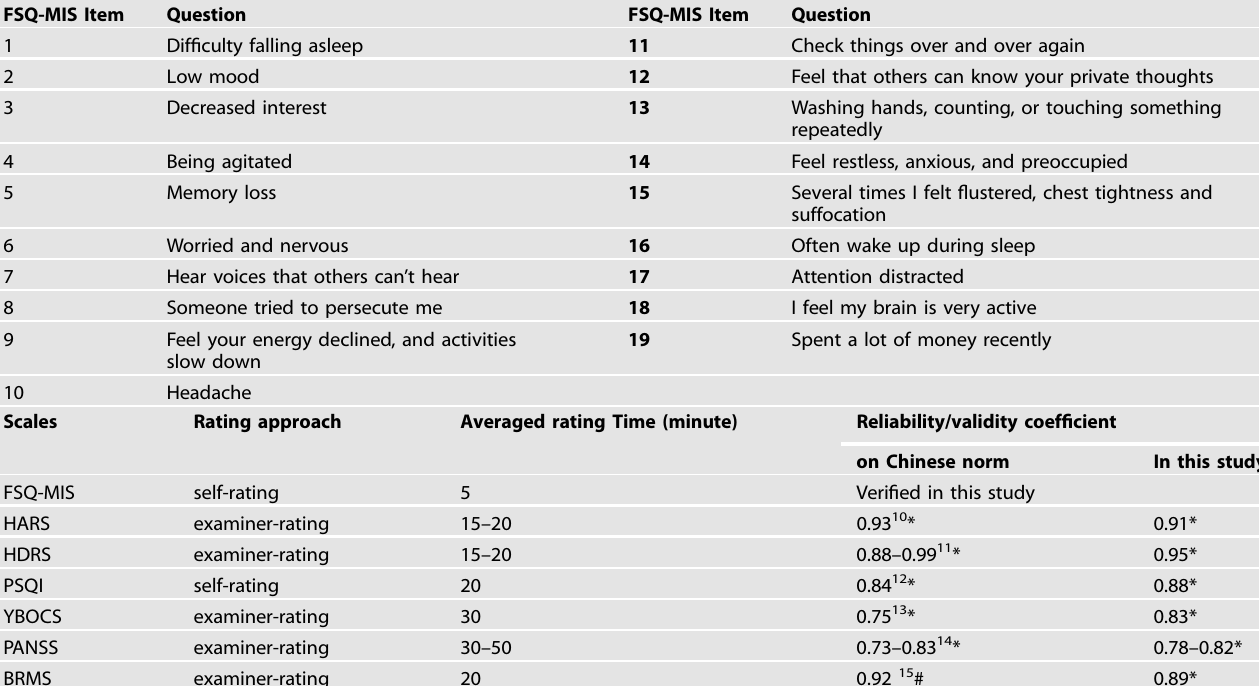
Table 1. Items of FSQ-MIS and the comparison with six